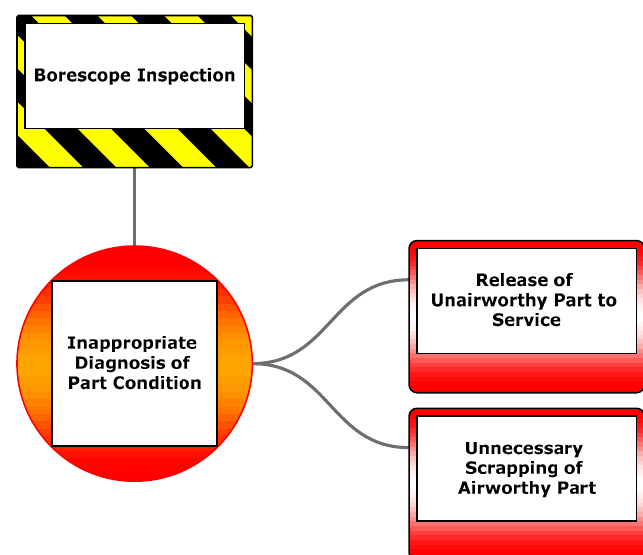
Figure 3. Bowtie diagram for “inappropriate diagnosis of part condition” with immediate consequences.